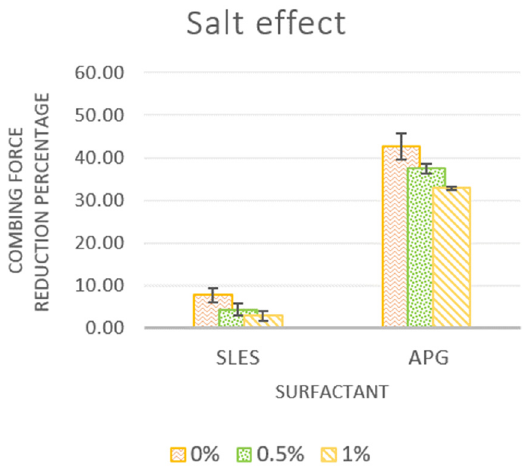
Figure 10. Wet combing reduction percentage for samples with different levels of salt, formulated with both SLES/CAPB and APG/CAPB at 12 wt. % and cationic polymer 0.5 wt. % at room temperature and pH ~7.